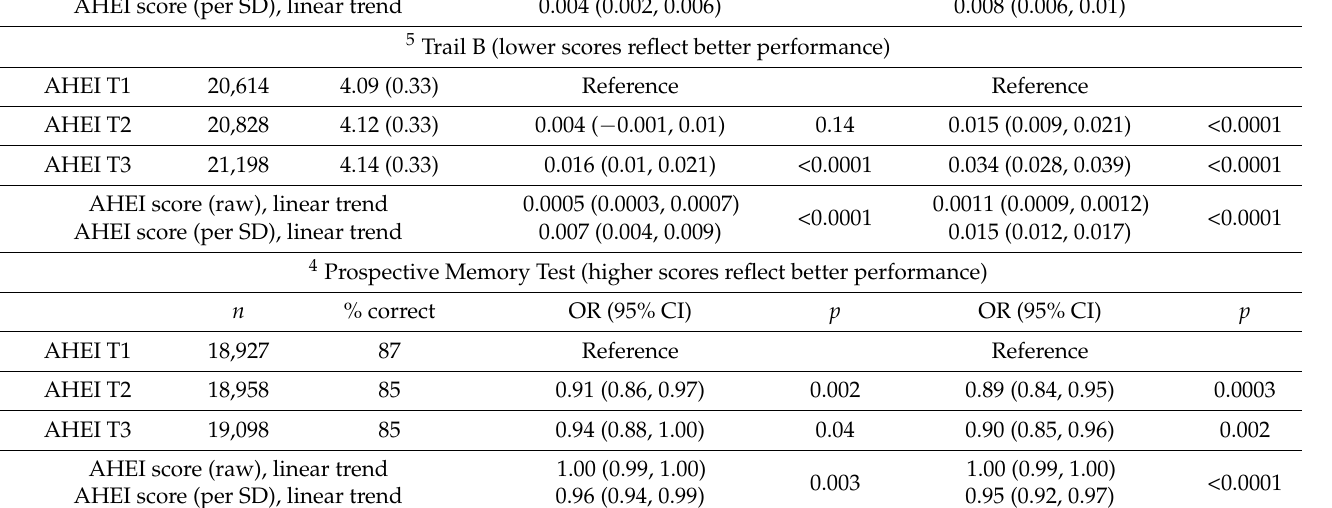
1 Model 1: adjusted for age, sex and self-reported race/ethnicity. 2 Model 2: adjusted for age, sex, race/ethnicity, education, Townsend deprivation index, income, employment status, family history of dementia; history of hypertension, diabetes, heart disease, stroke and depression; self-reported health, smoking, physical activity, BMI, fast meal consumption and energy intake. 3 Data are raw mean (SD) scores of each cognitive function test. 4 Positive beta-coefficients for FI (difference in 13-point score) and SDS (difference in number of correct substitutions) and OR > 1 for PM (correct on first attempt) correspond to higher performance compared to AHEI tertile 1. 5 Negative beta-coefficients for Pairs (difference in (log-transformed) number of errors), RT (difference in time, milliseconds, to respond), Trails A and Trails B (difference in (log transformed) time, deciseconds, to complete) correspond to higher performance compared to AHEI tertile